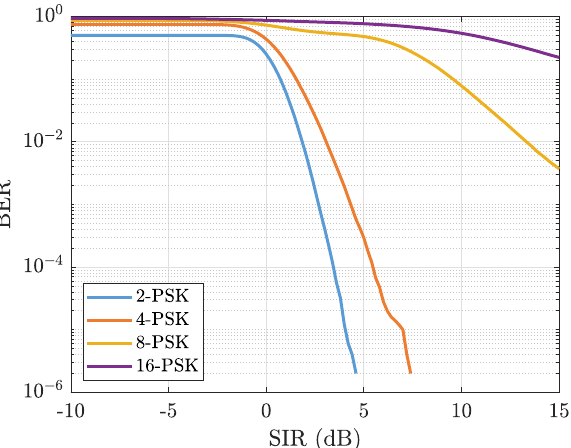
Figure 9. Alamouti 2 × 2 with the presence of the smart jammer. BER as a function of the SIR. Different modulation orders 2, 4, 8, 16–PSK and SNR = 15